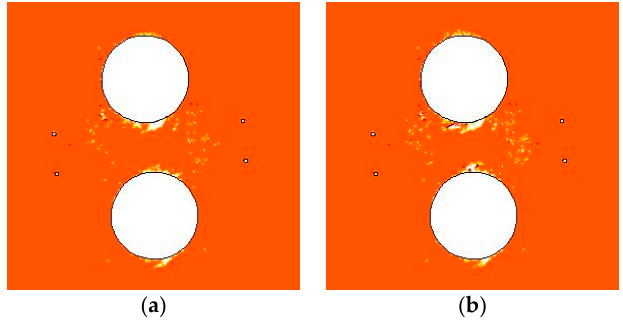
Figure 14. Damage zone distribution at day 60 of heating stage: ( a ) P